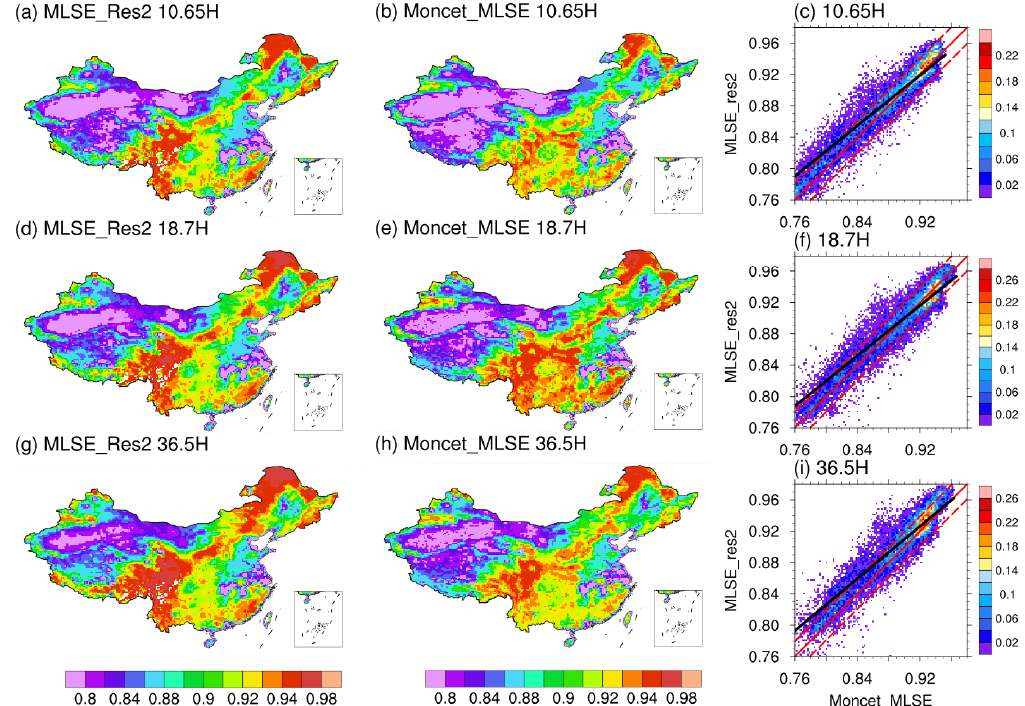
Figure 8. The same as Figure 7, but for comparison between MLSE_Res2 and Moncet_MLSE at 10.65 H ( a , d , g ), 18.7 H ( b , e , h ), and 36.5 H ( c , f , i Table 5. Statistical metrics of comparison of MLSE between MLSE_Res2 and Moncet_MLSE in China during summer 2003. Frequency